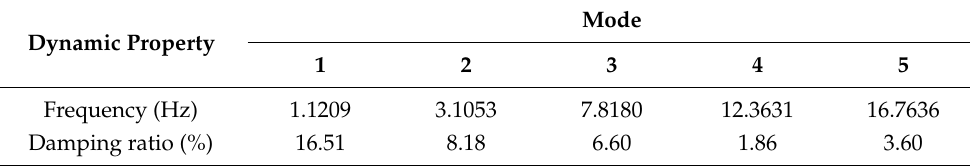
Figure 6. Amplitude and imaginary parts of the transfer function of the superstructure by WN05: ( a ) Basement; ( b ) First story; ( c ) Second story; ( d ) Third story; ( e ) Fourth story; ( f ) Fifth story. Table 6. Frequencies and damping ratios of the first five modes. Dynamic